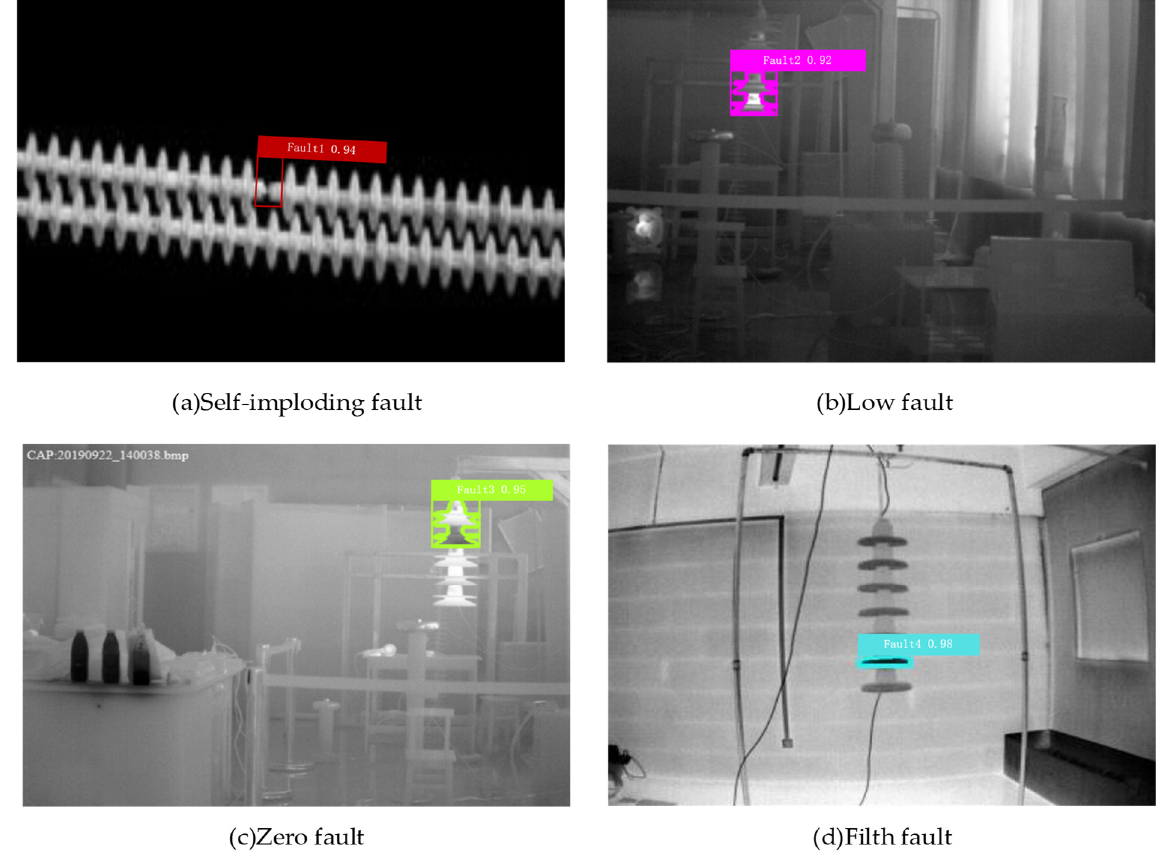
Sensors 2022 , 22 , 4720 Figure 10. Four typical troubleshooting results. Figure 10. Four typical troubleshooting results.